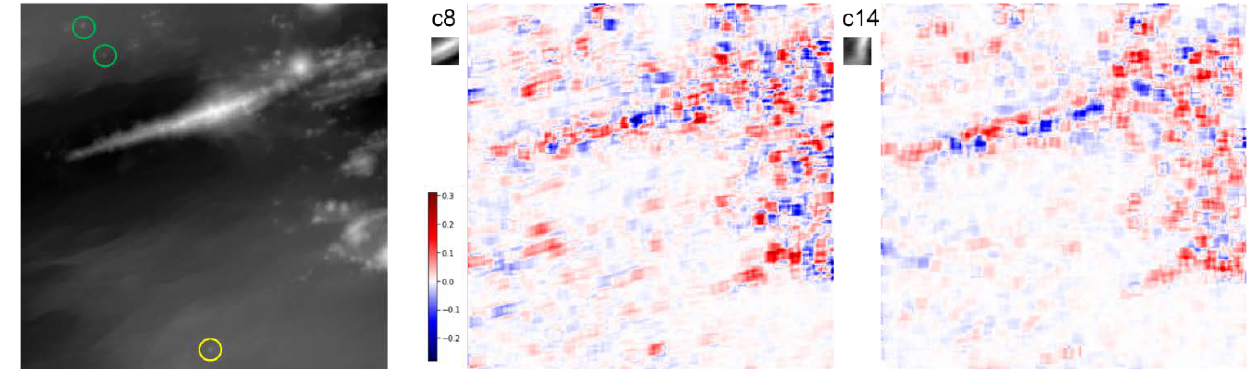
Figure 8. Distribution of clusters 8 and 14 based on the clustering (Figure 7) in the reconstructed area. The small figure to the top left of the coloured maps shows the representative basis within the cluster, that is, the one with the sum of the absolute values of the coefficients throughout the reconstruction is the largest in each cluster. The left figure shows the original image of the reconstructed area. The geological edifices in the green and yellow circles are the small sea knolls. See text for details.